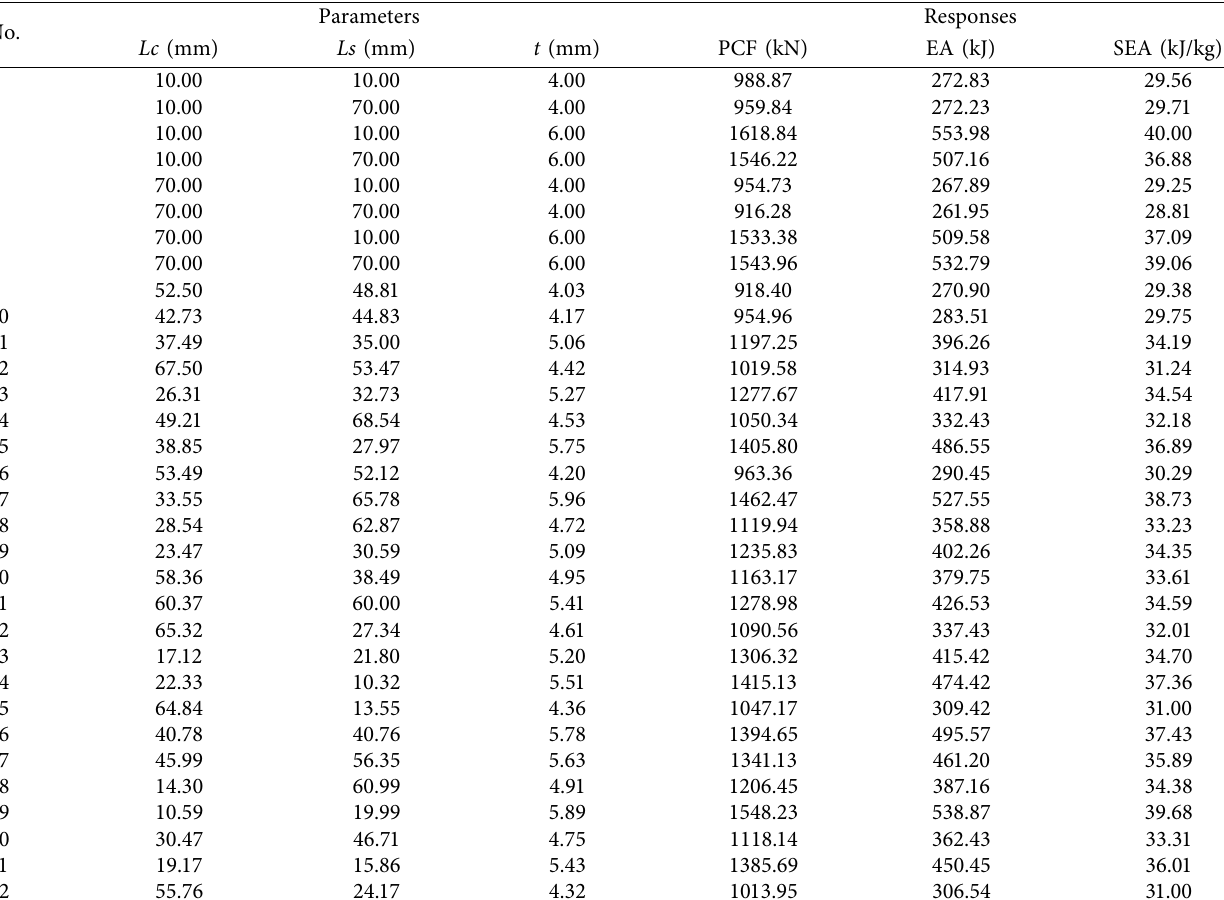
Table 5: Design matrixes of MCS-M.